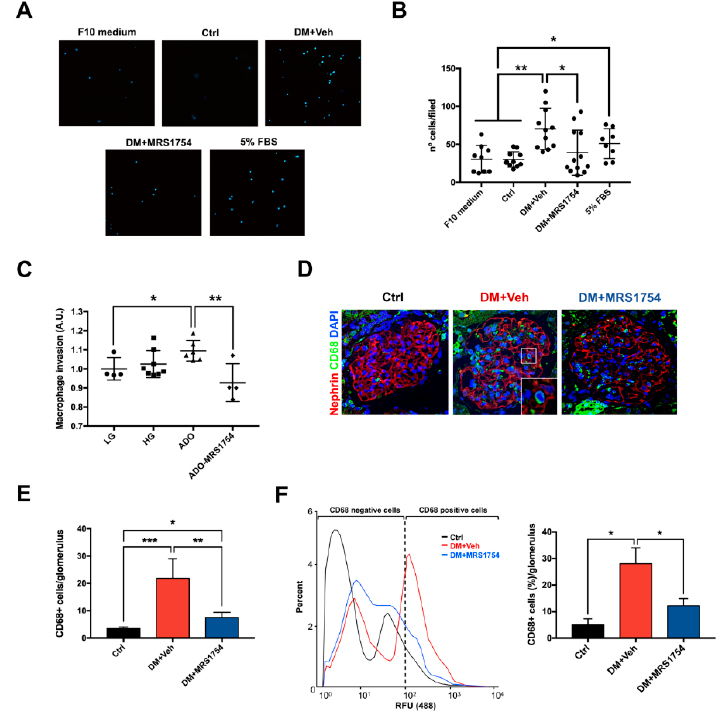
Figure 4. MRS1754 treatment decreases in vitro and in vivo macrophage cell migration and transmigration. ( A ) Migration of rat macrophages was evaluated for twelve hours in a transwell polycarbonate Boyden chamber under the chemoattractant effect of glomeruli-conditioned medium (CM) of non-diabetic (Ctrl), diabetic vehicle-treated (DM+Veh), and diabetic MRS1754-treated (DM+MRS1754) rats. F10 medium and 5% fetal bovine serum (FBS) were used as negative and positive controls, respectively, for macrophage cell migration. 4’,6-diamidino-2-phenylindole (DAPI) was used to stain the nuclei of macrophages. ( B ) Graphs represent the macrophage number per field (nº cells/filed) in (A)). ( C ) Cell transmigration (arbitrary unit = A.U.) of human macrophages was tested for twenty-four hours in transwell polycarbonate Boyden chamber coated with growth-factor-reduced basement membrane extract (BME) under the chemoattractant effect of 5% FBS and incubated in low D-glucose (LG; 5 mM D-glucose) or high D-glucose (HG; 25 mM D-glucose) medium. Additionally, the HG condition was supplemented with adenosine (ADO; 1 μ M) and MRS1754 (10 nM). ( D ) Immunohistofluorescence of CD68 (macrophage marker; green color) and nephrin (podocyte marker; red) in the glomeruli of non-diabetic (black; Ctrl), diabetic (red; DM+Veh), and diabetic MRS1754-treated (blue; DM+MRS1754) rats at twelve weeks post-STZ inoculation. DAPI (blue) was used as a counterstain. The box at lower right corner of the middle image represents a magnification of the selected area. ( E ) Graphs represent quantification of CD68+ cells per glomerulus in (D). ( F ) Flow cytometry for the CD68 macrophage marker in collagenase-digested glomeruli of non-diabetic (black; Ctrl), diabetic (red; DM+Veh), and diabetic MRS1754-treated (blue; DM+MRS1754) rats at twelve weeks post-STZ inoculation. Histogram (left panel) and graph (right panel) of the percentage of CD68+ cells in rat glomeruli. Relative fluorescence units = RFU. Graphs represent the mean ± S.D. * p < 0.05, ** p < 0.01, *** p < 0.005 between groups. n = 4. Selected glomerulus area with a 400x magnification.